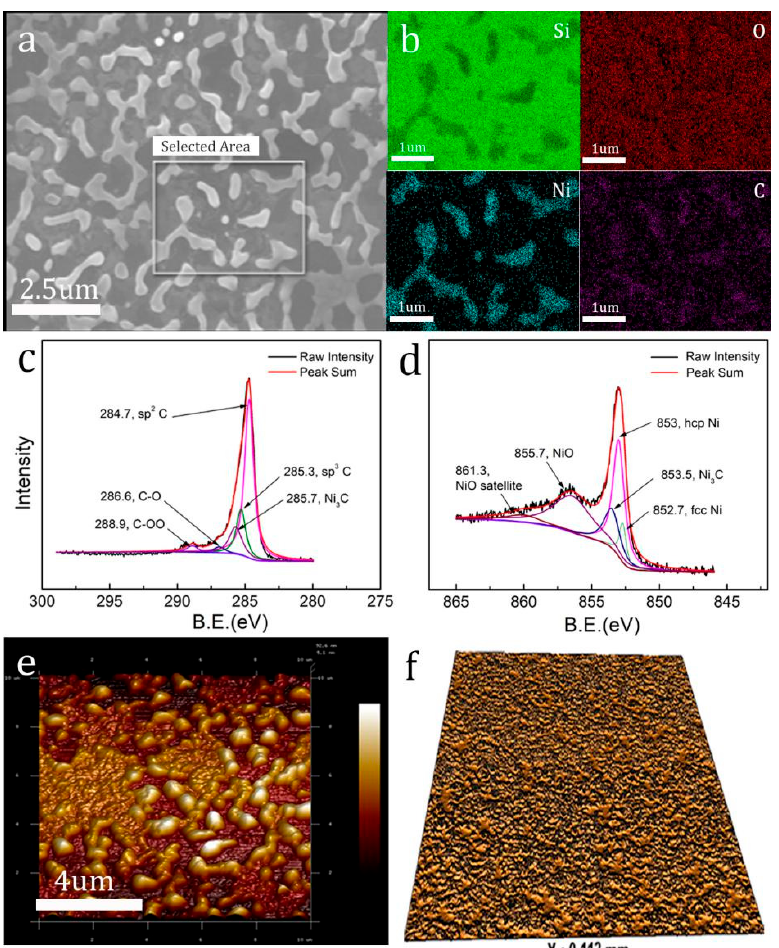
Figure 3. ( a ) SEM image of as ‐ grown graphene film on Si wafer surface; ( b ) the corresponding SEM elemental mapping image, scale bar is 1 um. Green, red, cyan and purple dots indicate Si, O, Ni and C atoms, respectively; ( c , d ) XPS spectra of C1s and Ni2p for as ‐ grown graphene film on Si wafer surface; ( e ) AFM image of surface morphology of the as ‐ grown graphene film with a size of 10 um × 10 um; ( f ) image of surface morphology of the as ‐ grown graphene film with a size of 113 um × 113 um by using white light interferometer.